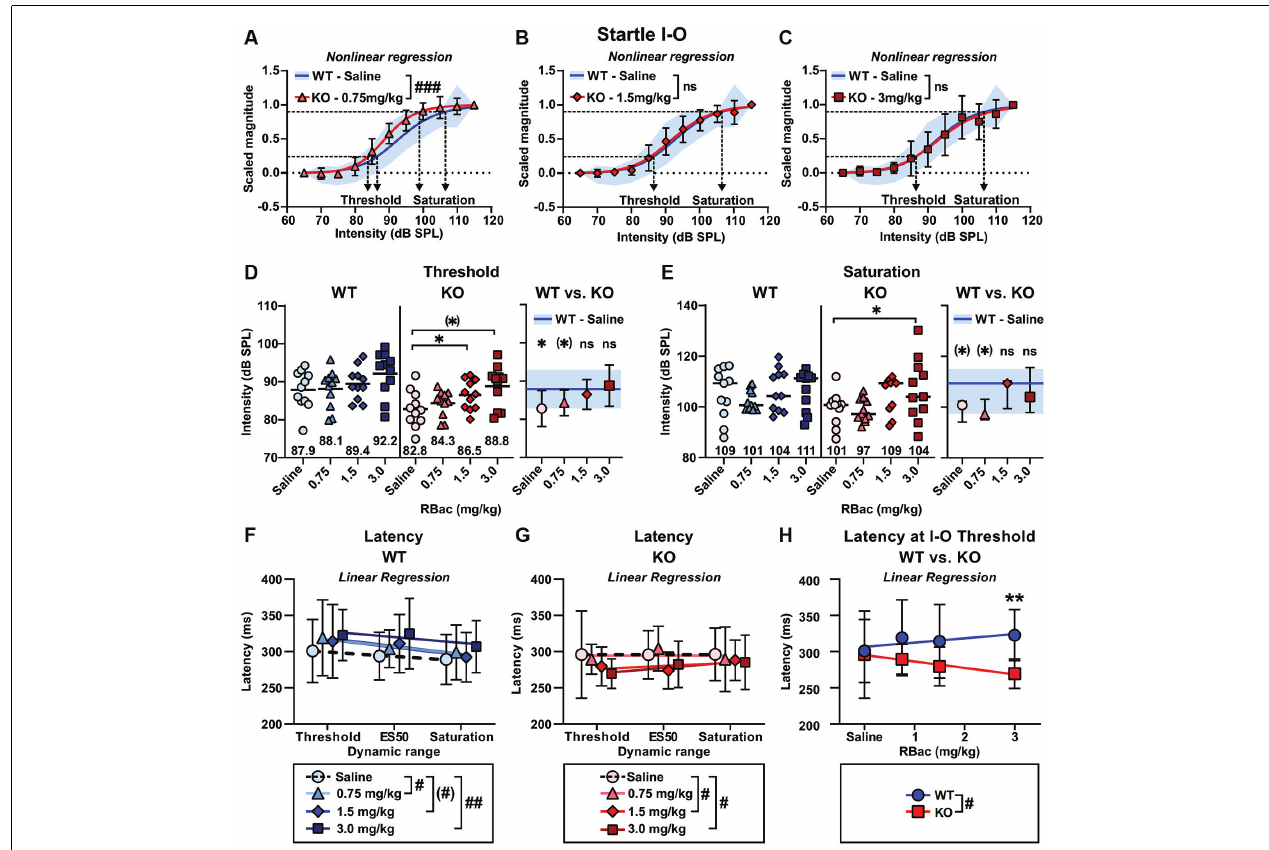
FIGURE 7 | Medium and high doses of R-Baclofen increase ASR I-O threshold and saturation in Cntnap2 KO rats close to controls but shorten ASR peak latencies. (A–C) Sigmoidal curves (lines) fitted to the startle magnitudes scaled between 0 and 1 in Cntnap2 WT rats with saline (SD, blue area) and Cntnap2 KO rats (mean ± SD) with 0.75 mg/kg ( A , red triangles and error bars), 1.5 mg/kg ( B , red diamonds and error bars), and 3 mg/kg R-Baclofen ( C , red squares and error bars). Dotted horizontal line at 0.25 determined as ASR threshold and at 0.9 as ASR saturation (curve fit values see Table 3 ). The average curve fit was significantly different from controls in Cntnap2 KO rats after administration of 0.75 mg/kg ( A , p < 0.0001, F (2,238) = 12.12), but similar to controls with 1.5 mg/kg ( B , p = 0.6048, F (2,238) = 0.5039), and 3 mg/kg R-Baclofen ( C , p = 0.7751, F (2,238) = 0.2550). (D) Individual ASR thresholds in Cntnap2 WT ( Left ), KO ( Middle ), and WT vs. KO rats ( Right ) extracted from individual sigmoidal curve fits (ASR threshold values see Supplementary Table 2 ). (D, Left) Mean ASR thresholds were not significantly increased in Cntnap2 WT rats with R-Baclofen (0.75 mg/kg: light blue triangles and horizontal black line, 1.5 mg/kg: blue diamonds and horizontal black line, 3 mg/kg: dark blue squares and horizontal black line) compared to saline (circles and horizontal black line, RM ANOVA, p = 0.0685). (D, Middle) Mean ASR thresholds were significantly increased in Cntnap2 KO rats with R-Baclofen compared to saline (saline: circles and horizontal black line, 0.75 mg/kg: light red triangles and horizontal black line, 1.5 mg/kg: red diamonds and horizontal black line, 3 mg/kg: dark red squares and horizontal black line, RM ANOVA, p = 0.0291, Dunnett’s multiple comparisons test, saline vs. 0.75 mg/kg: p = 0.5583, saline vs. 1.5 mg/kg: p = 0.0315, saline vs. 3 mg/kg: p = 0.0784). (D, Right) Mean ± SD ASR thresholds in Cntnap2 KO rats were significantly different from WT controls (after saline, blue line and area) with saline (two-sided student’s t -test, p = 0.0244), not quite significantly different with 0.75 mg/kg (two-sided student’s t -test, p = 0.0690), and similar to controls with 1.5 mg/kg (two-sided student’s t -test, p = 0.4839) and 3 mg/kg R-Baclofen (two-sided student’s t -test, p = 0.6819). (E) Individual ASR saturation levels in Cntnap2 WT ( Left ), KO ( Middle ), and WT vs. KO rats ( Right ) extracted from individual sigmoidal curve fits (ASR saturation values see Supplementary Table 2 ). (E, Left) Median ASR saturation levels were not significantly altered in Cntnap2 WT rats with R-Baclofen (0.75 mg/kg: light blue triangles and horizontal black line, 1.5 mg/kg: blue diamonds and horizontal black line, 3 mg/kg: dark blue squares and horizontal black line) compared to saline (circles and horizontal black line, Friedman test, p = 0.5915). (E, Middle) Median ASR saturation levels were significantly increased in Cntnap2 KO rats with R-Baclofen compared to saline (saline: circles and horizontal black line, 0.75 mg/kg: light red triangles and horizontal black line, 1.5 mg/kg: red diamonds and horizontal black line, 3 mg/kg: dark red squares and horizontal black line, Friedman test, p = 0.0240, Dunn’s multiple comparisons test, saline vs. 0.75 mg/kg: p > 0.9999, saline vs. 1.5 mg/kg: p = 0.2959, saline vs. 3 mg/kg: p = 0.0150). (E, Right) Median ± interquartile range (IQR) ASR saturation levels in Cntnap2 KO rats were by tendency different from WT controls (after saline, blue line and area) with saline (Mann–Whitney test, p = 0.0879) and 0.75 mg/kg (Mann–Whitney test, p = 0.0879), and similar to controls with 1.5 mg/kg (Mann–Whitney test, p = 0.7477) and 3 mg/kg R-Baclofen (Mann–Whitney test, p = 0.8470). (F,G) Linear regression of ASR peak latencies across the dynamic range of Cntnap2 WT (F) and KO (G) rats with saline or R-Baclofen (mean ± SD, linear regression fits see Table 4 ). Elevations of the regression lines were significantly different in Cntnap2 WT ( F , p = 0.0034, F (3,7) = 12.46; saline vs. 0.75 mg/kg: p = 0.0202, F (1,3) = 20.50; saline vs. 1.5 mg/kg: p = 0.0620, F (1,3) = 8.468; saline vs. 3 mg/kg: p = 0.0099, F (1,3) = 34.45) and KO rats (G ; p = 0.0336, F (3,7) = 5.192; saline vs. 0.75 mg/kg: p = 0.8075, F (1,3) = 0.07070; saline vs. 1.5 mg/kg: p = 0.0375, F (1,3) = 12.76; saline vs. 3 mg/kg: p = 0.0272, F (1,3) = 16.37). (H) Linear regression of ASR peak latencies near threshold across treatment in Cntnap2 WT (blue circles and error bars, mean ± SD) and KO rats (red squares and error bars, mean ± SD). Slopes of the regression lines were significantly different ( p = 0.0116, F (1,4) = 19.41; WT: blue line, Y = 5.893 * X + 306.6, Sy. x = 7.147; KO: red line, Y = − 8.876 * X + 295.3, Sy. x = 2.057). ( ∗ ) p < 0.1; ∗ p < 0.05; ∗∗ p < 0.01; comparison of regression lines: ( # ) p < 0.1; # p < 0.05; ## p < 0.01; ### p < 0.001, n.s., not